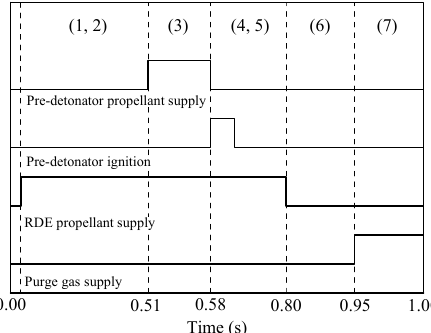
Figure 6. Pressure history of plenums, combustion channel, and pre-detonator at 𝑚(cid:4662) = 80.3 ± 0.20 g/s for Φ = 1.04 ± 0.001 (( a ) overall operation, ( b ) combustion phase).